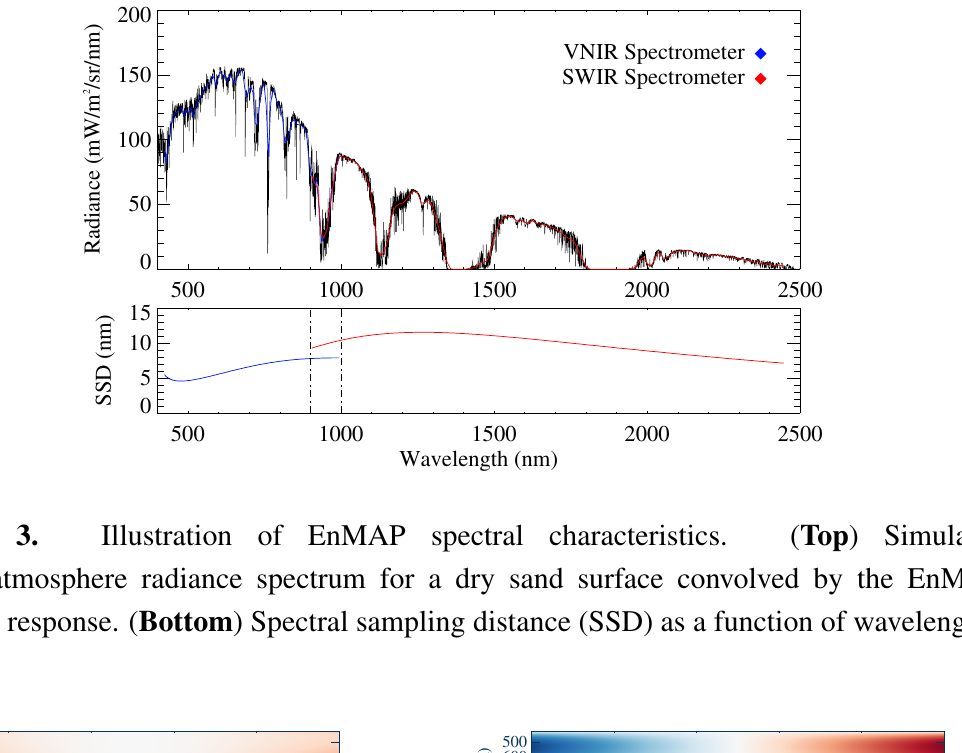
Figure 4. Characteristic spectral “smile” and “frown” (inverse smile) patterns can be observed along the across-track direction of the SWIR spectrometer at, e.g., 1000- and 2400-nm wavelength positions, respectively. Peak values of smile are about − 0.5 nm ( ∼ 5% of a spectral pixel) at the long wavelength edges of the two spectrometers, which is to be compared with the up to 4-nm variation in spectral channel position at 760 nm for Hyperion [51]. Keystone is generally below 3% of a spatial pixel for the EnMAP VNIR spectrometer and almost negligible in the SWIR spectrometer. These numbers for smile and keystone largely improve upon the < 20 % mission requirement (see Table 1).